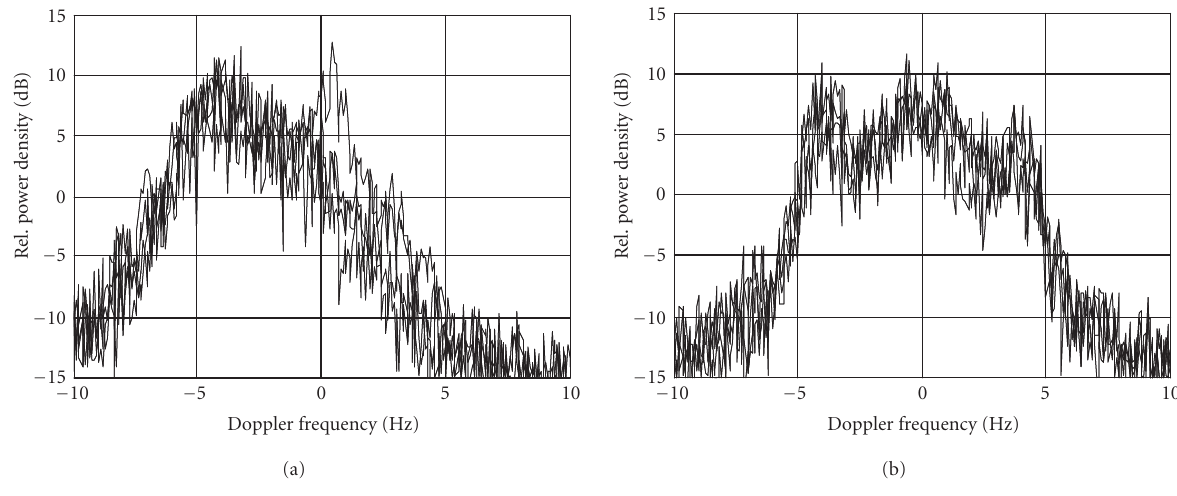
Figure 10: Average Doppler spectra outdoor-to-indoor for (a) helix ( τ 1 = 0 nanoseconds, p 1 = − 10 . 6dB) and (b) PIFAs ( τ 1 = 0 nanosec- onds, p 1 = 0dB): tap 1 of star BS2 configuration, handset free in air, “at the